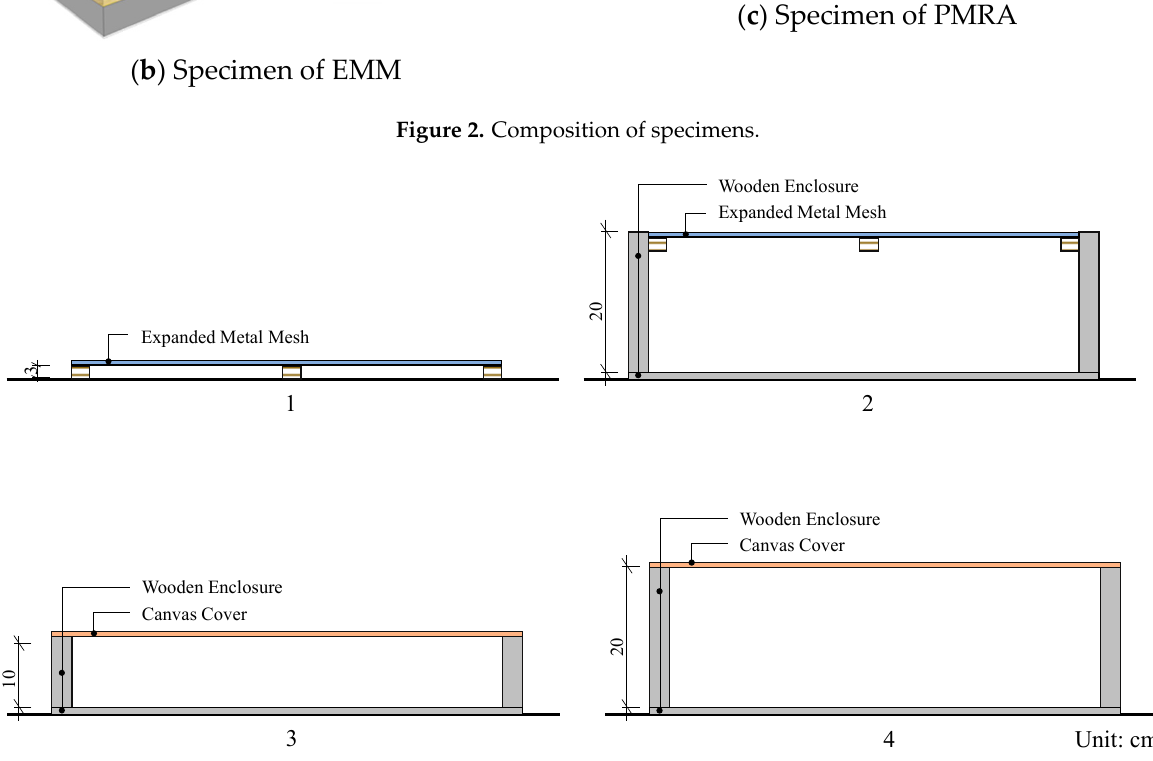
Figure 3. Specimen section in stage 1, as table 1.